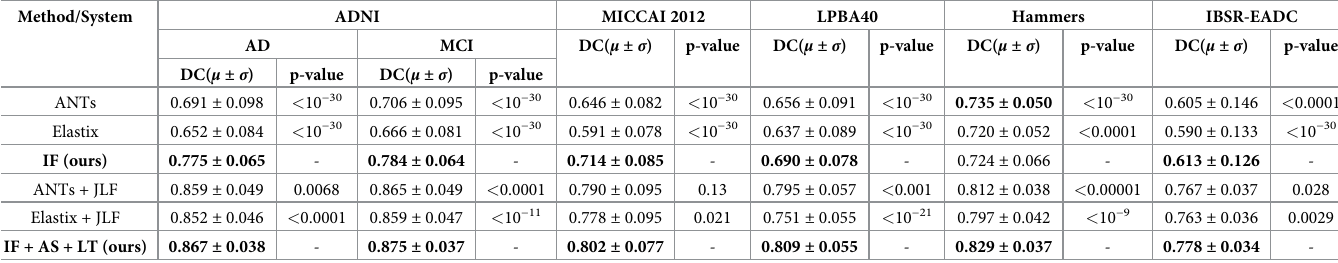
Table 4. Dice coefficient evaluation results of three registration methods and three best-performing systems on five datasets.